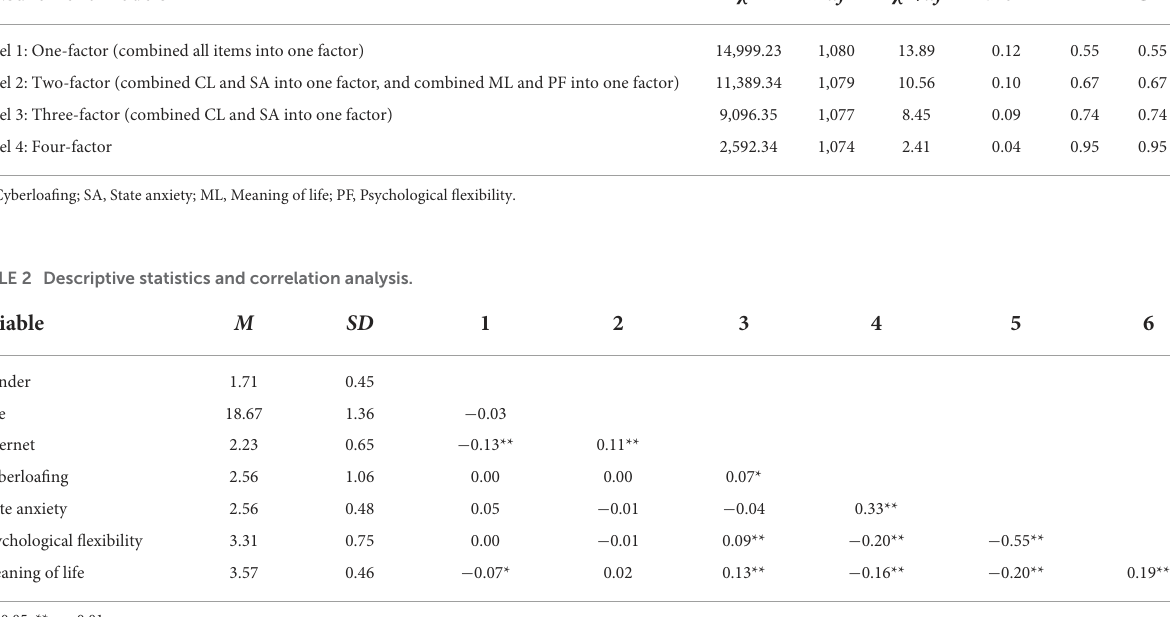
TABLE 1 Results of confirmatory factor analysis of the measurement models. Measurement models